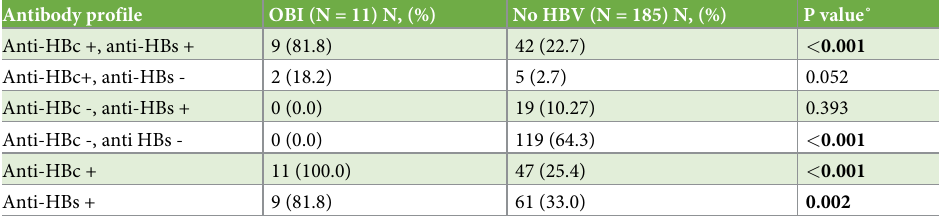
Table 2. Antibody profiles of OBI and HBV DNA negative patients.